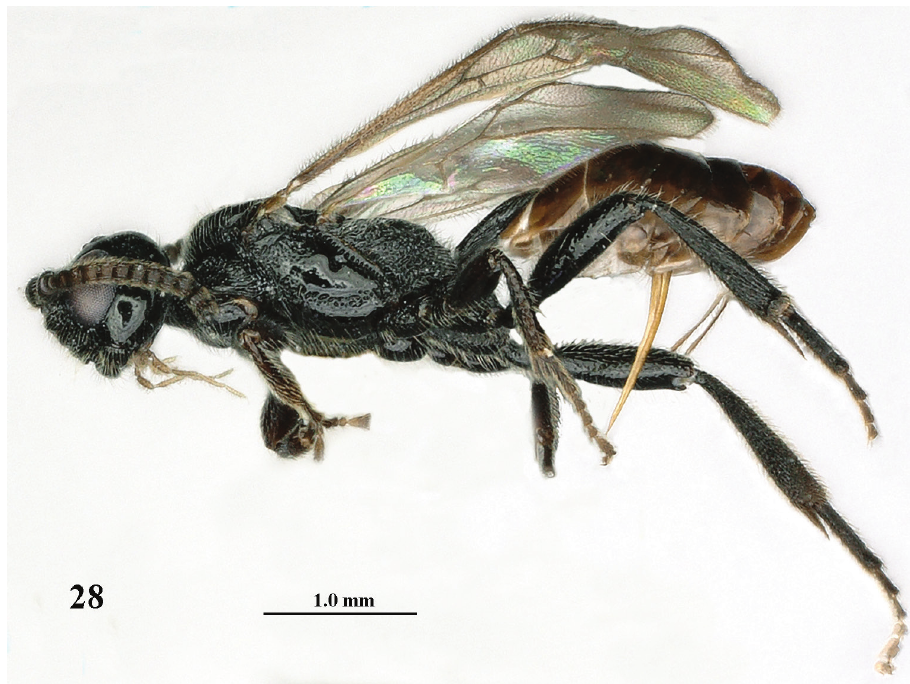
Figure 28. Mannokeraia nigrita sp. n., ♀ , holotype, habitus, lateral aspect.